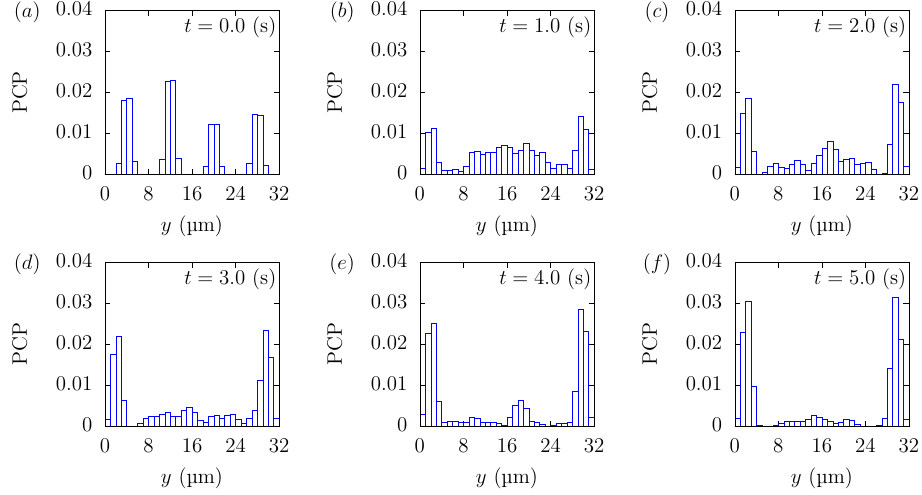
Figure 10. Particle Concentration Profiles (PCPs) in a straight channel of 224 × 32 × 32 µ m for ˙ γ w = 712 s − 1 , Ht = 40% at ( a ) t = 0, ( b ) t = 1.0, ( c ) t = 2.0, ( d ) t = 3.0, ( e ) t = 4.0, and ( f ) 5.0 s. Each graph corresponds to the results in Figure 9.